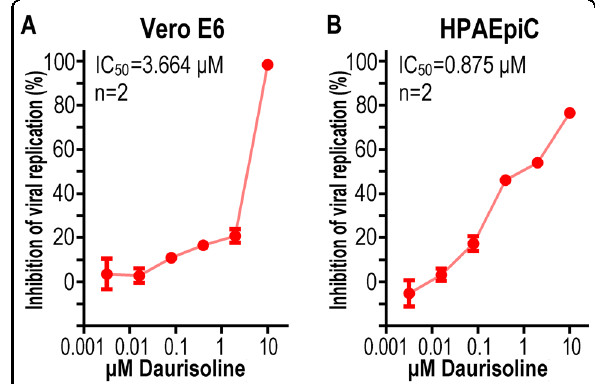
Fig. 8 Daurisoline could inhibit SARS-CoV-2 replication in Vero E6 cells and HPAEpiC cells. a Antiviral assay showed inhibition of viral replication in dependency of Daurisoline concentration in Vero E6 cells ( n = 2). b Antiviral assay showed inhibition of viral replication in dependency of Daurisoline concentration in HPAEpiC cells ( n =